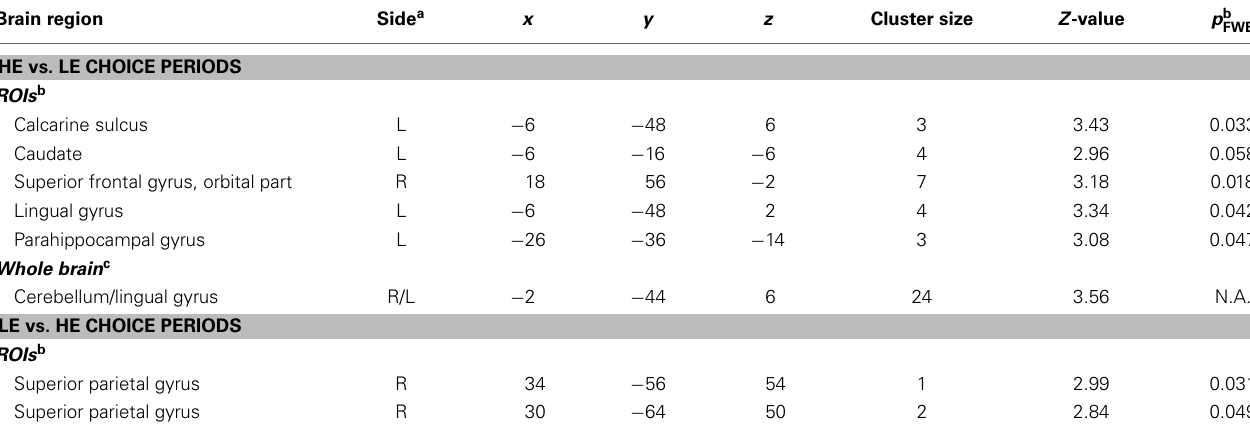
Table 2 | Brain regions differentially activated in response to HE and LE choice periods. Brain